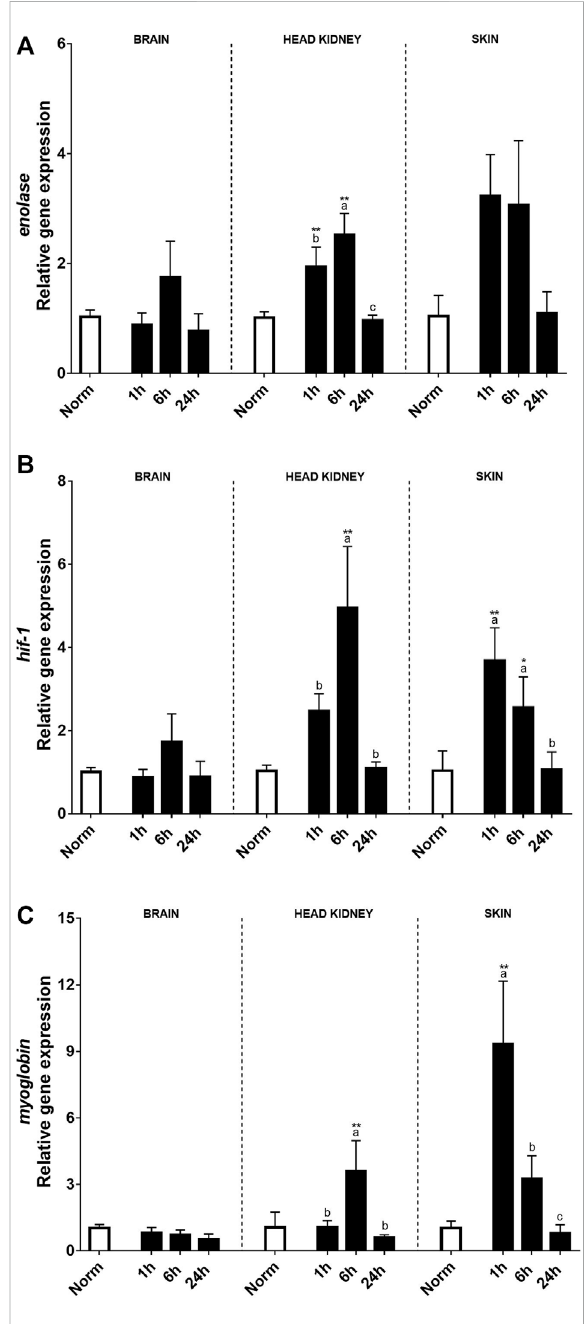
FIGURE 3 Transcript levels of (A) enolase , (B) hyf-1 , and (C) myoglobin in rainbow trout brain, head kidney, and skin after normoxia and after acute hypoxia with different recovery times (1, 6, and 24 h). The values are presented as mean +SEM ( n = 8). Signi fi cant differences between time points after hypoxia are shown by letters; between hypoxia-treated and normoxia are shown by * ( p < 0.05) or ** ( p <